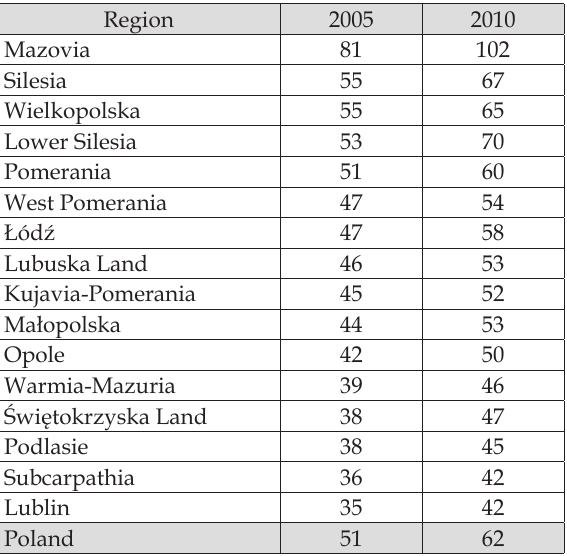
Table 8. Per capita GDP as per cent of the EU average (PPS, EU27 =